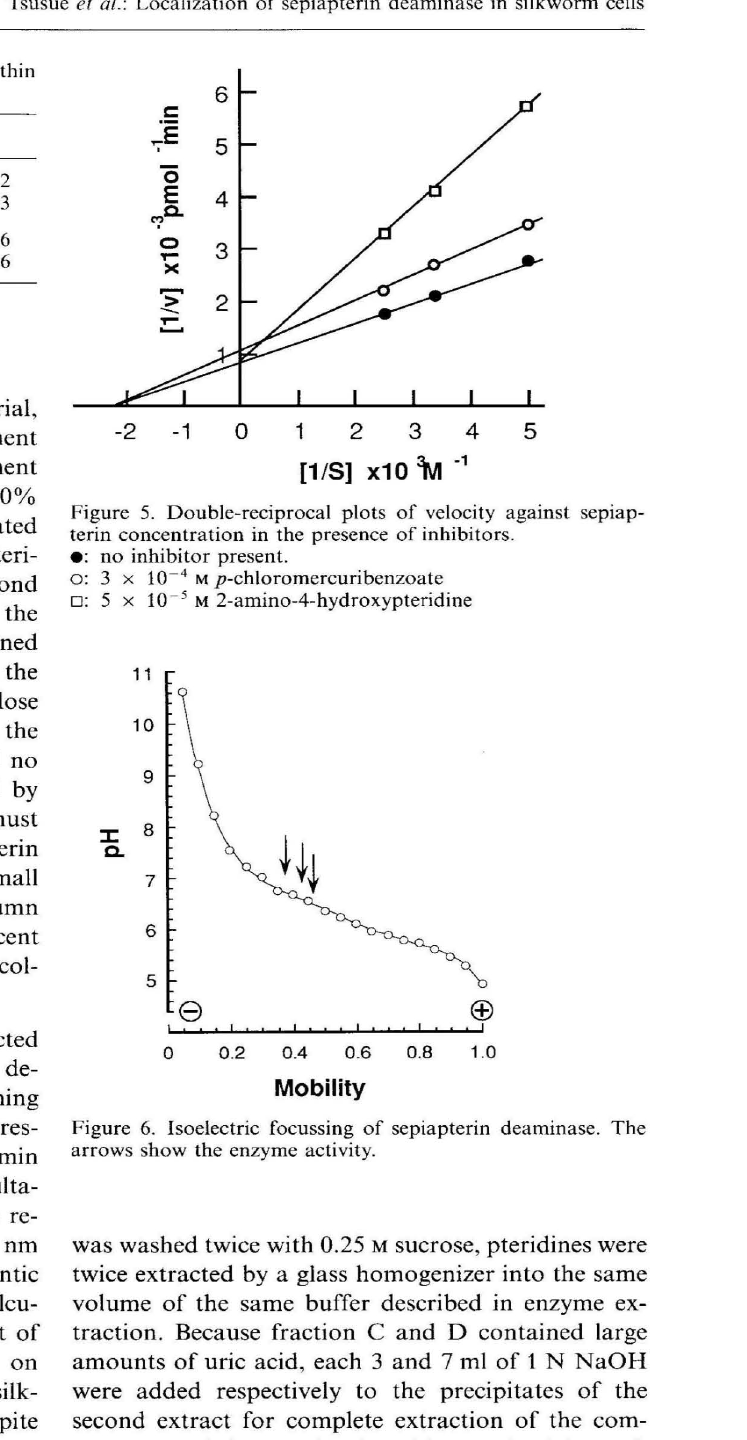
Table 4. Rf values of isoxanthopterin and leucopterin by thin layer chromatography